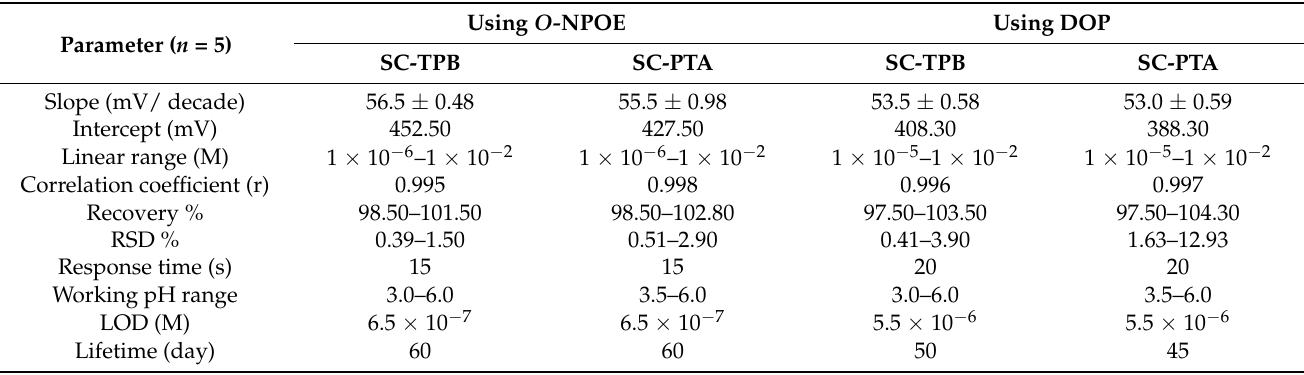
Figure 2. Potentiometric response of the PVC-O-NPOE membrane sensors plasticized (a) SC-TPB and (b) SC-PTA. Table 1. Potentiometric response characteristics performance of the SC-TPB and SC-PTA with PVC plasticized with O- NPOE and